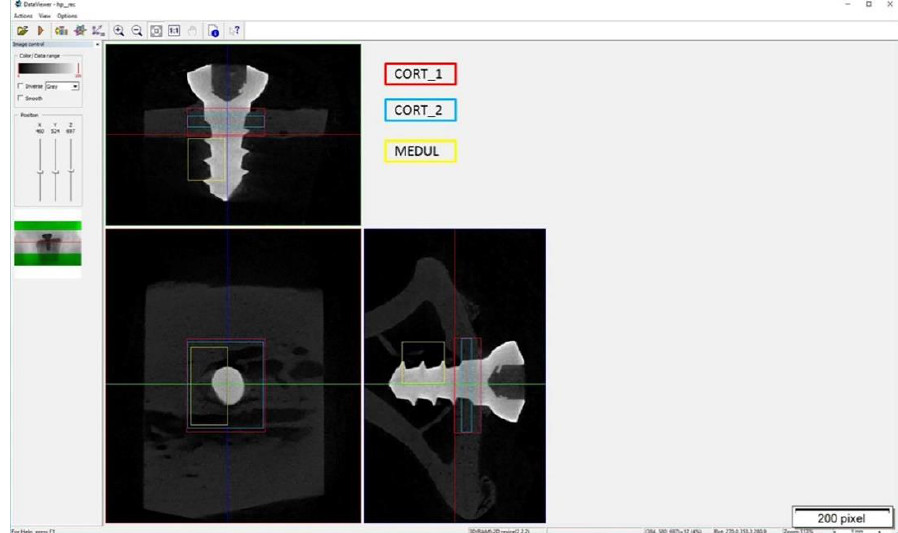
Figure 1. Evaluation on one sample by Data Viewer Software for measuring bone-to-implant contact (BIC) (cortical and medullar).